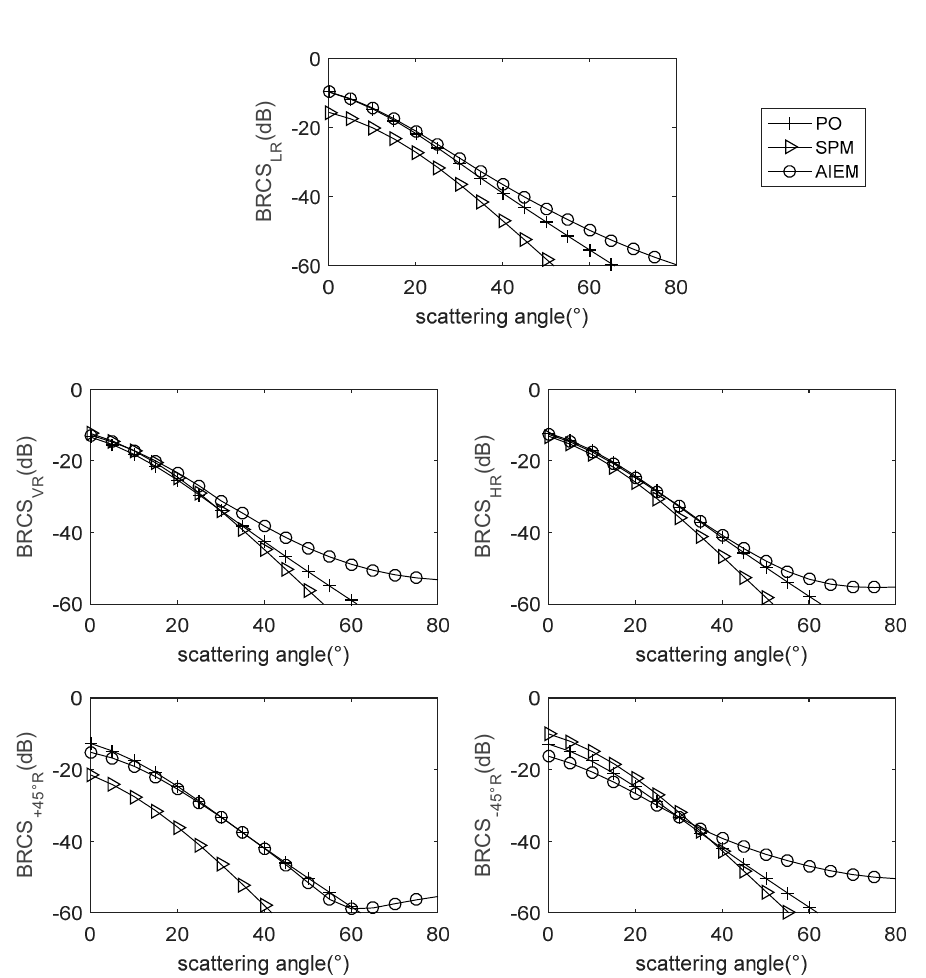
Figure 5. Scattering zenith angles’ e ff ects on BRCS at five di ff erent polarizations. θ i = 30 ◦ , θ s = 30 ◦ , ϕ s = 0 ◦ . Subfigures a to e represent the polarizations of LR, VR, HR, + 45 ◦ R and − 45 ◦ R, res pectively.